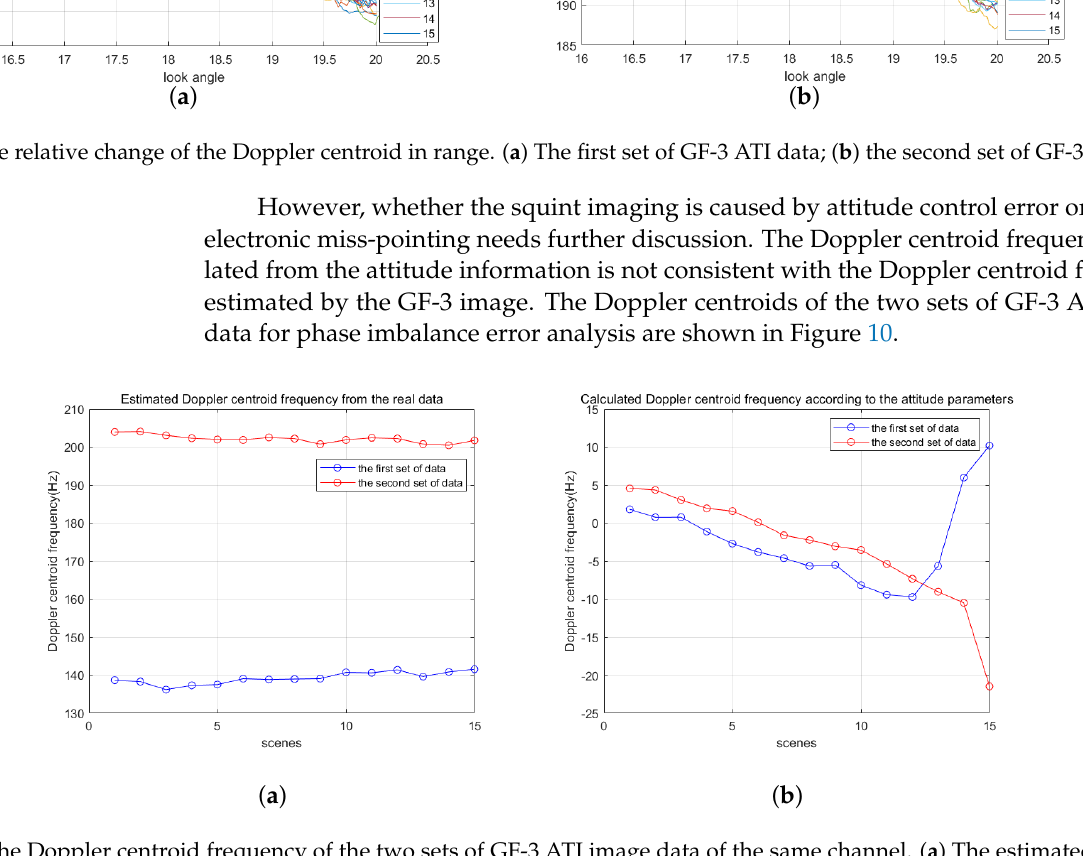
Figure 10. The Doppler centroid frequency of the two sets of GF-3 ATI image data of the same channel. ( a ) The estimated Doppler centroid frequency from real data; ( b ) the calculated Doppler centroid frequency according to the attitude